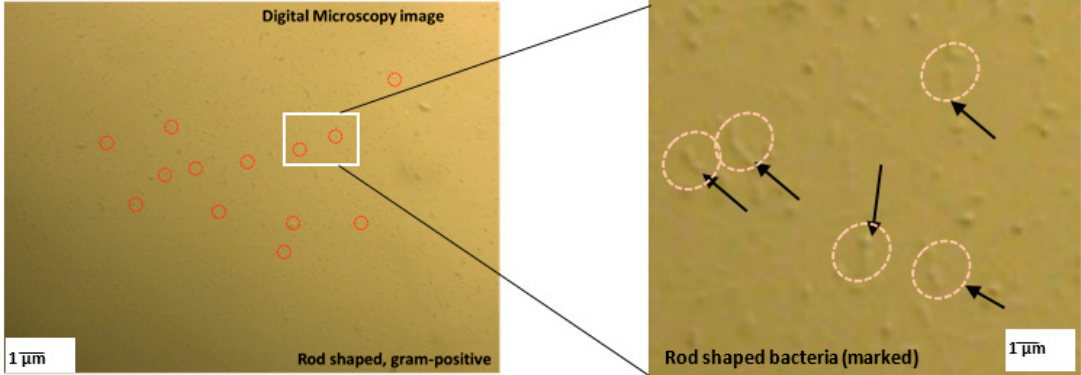
Figure 3. Digital microscopic image of the microorganism used in this study.